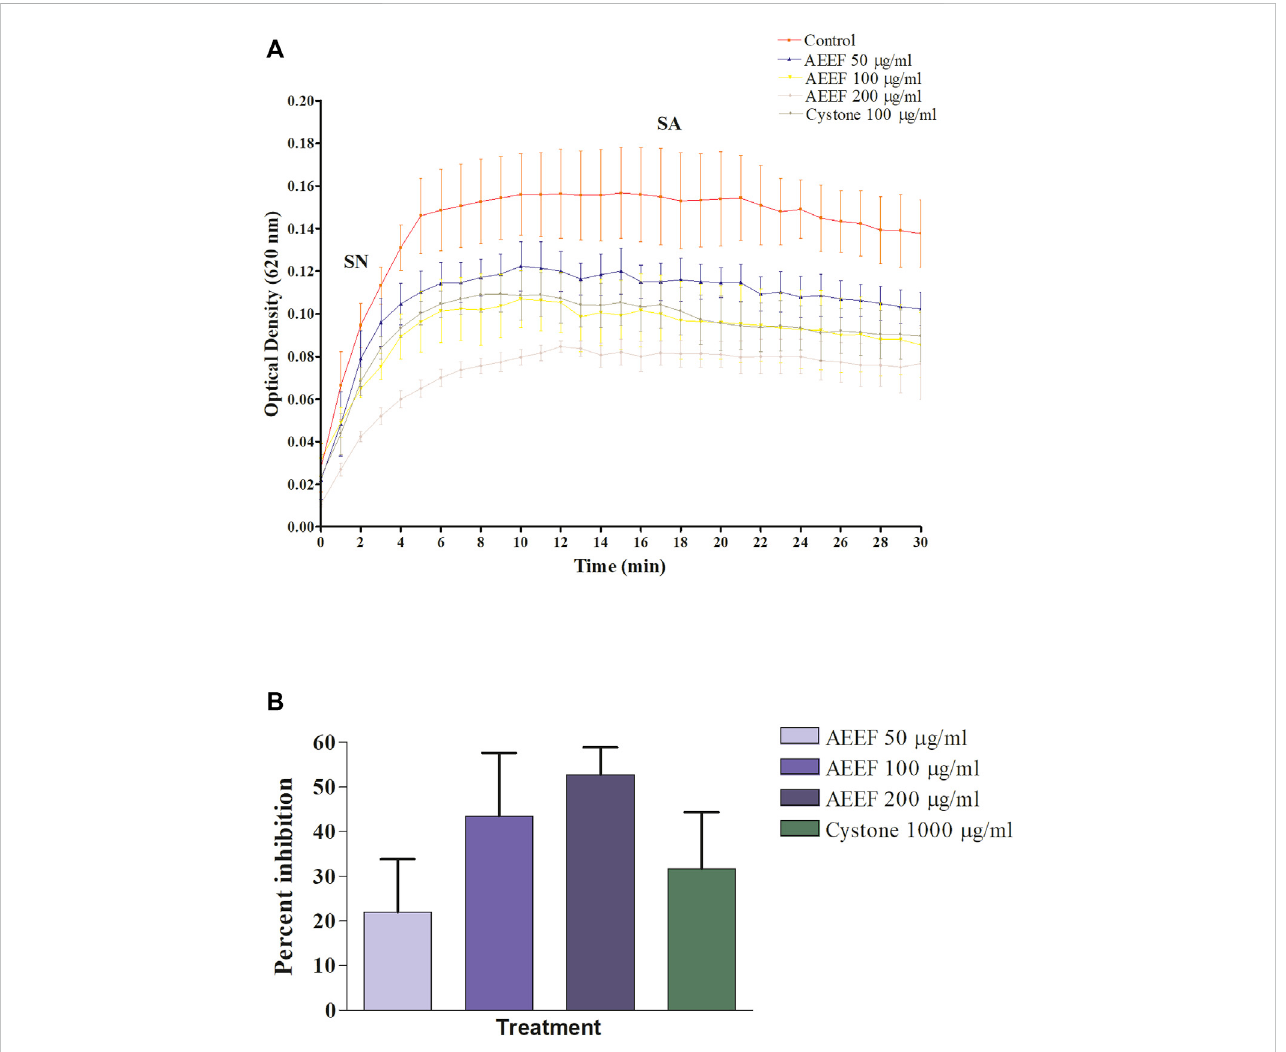
FIGURE 1 EffectofAEEFonCaOxcrystallization (A) Changeintheopticaldensityofdifferentsolutionsatdifferenttimeintervals (B) Percentinhibitionofnucleation. Values are expressed as mean ± S.D. (n =